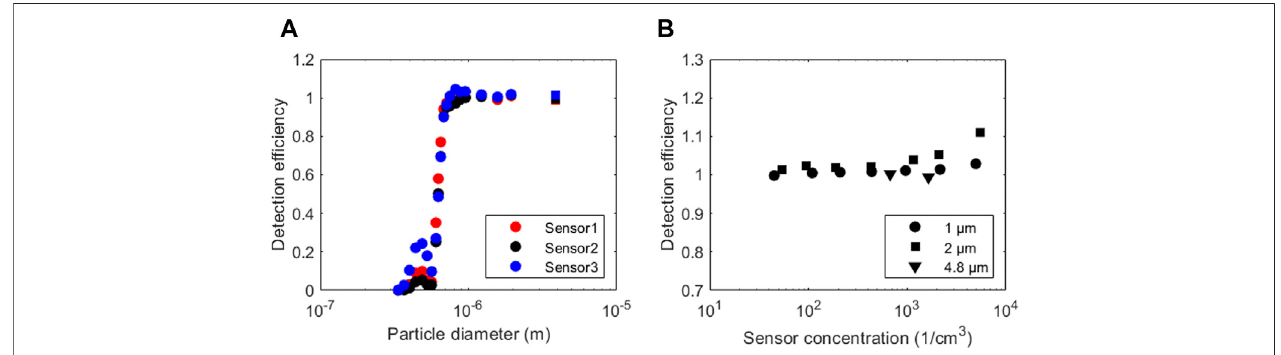
FIGURE 4 | Detection ef fi ciency as a function of particle diameter (A) and as a function of particle concentration (B) . In fi gure (A) points marked with circles refer to CPC-based points and points marked with squares refers to a point where Sensor two was calibrated with the FCAE and other sensors were compared to Sensor 2. In fi gure (B) detection ef fi ciency of Sensor 2 as a function of concentration is presented for three different particle